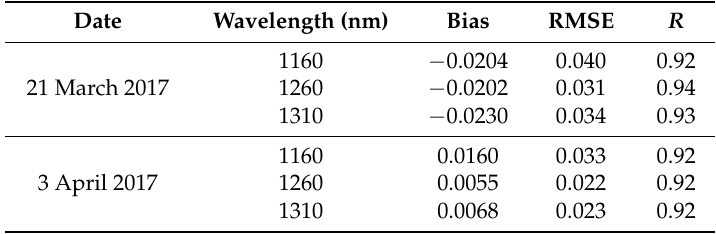
Table 2. Bias, root-mean-square error (RMSE) and correlation coefficient ( R ) for QST reflectances from the snowpack profile and the sampled